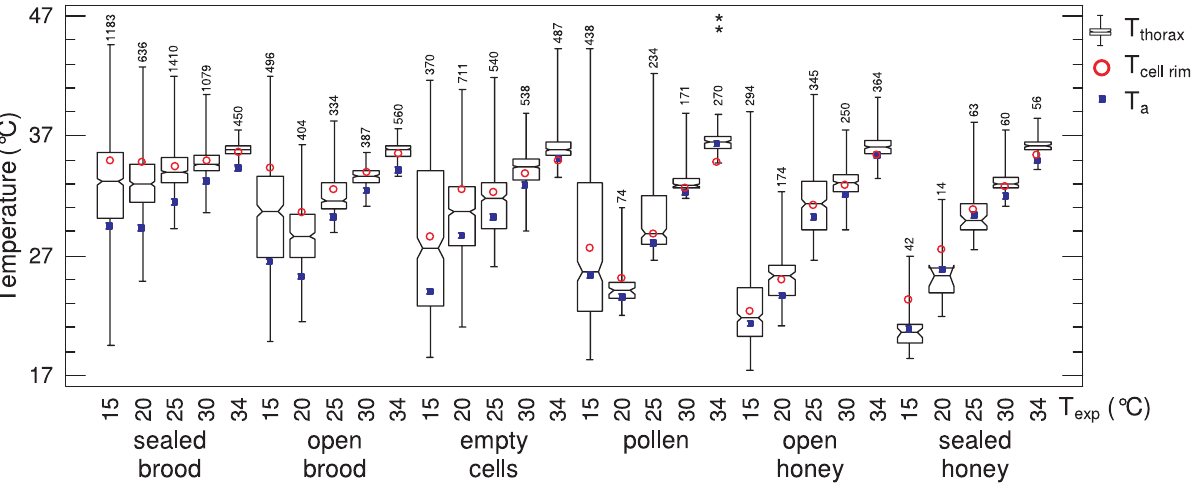
Figure 2. Worker honeybee thorax temperature on different locations in the observation colonies in dependence on cold stress (T exp ). Box plots: median T thorax with 1 st and 3 rd quartile, maximum and minimum. Notches which do not overlap indicate significant differences (P , 0.05). T cell rim and T a : medians. Numbers = n (T thorax ). * are two bees during intense examination by hivemates